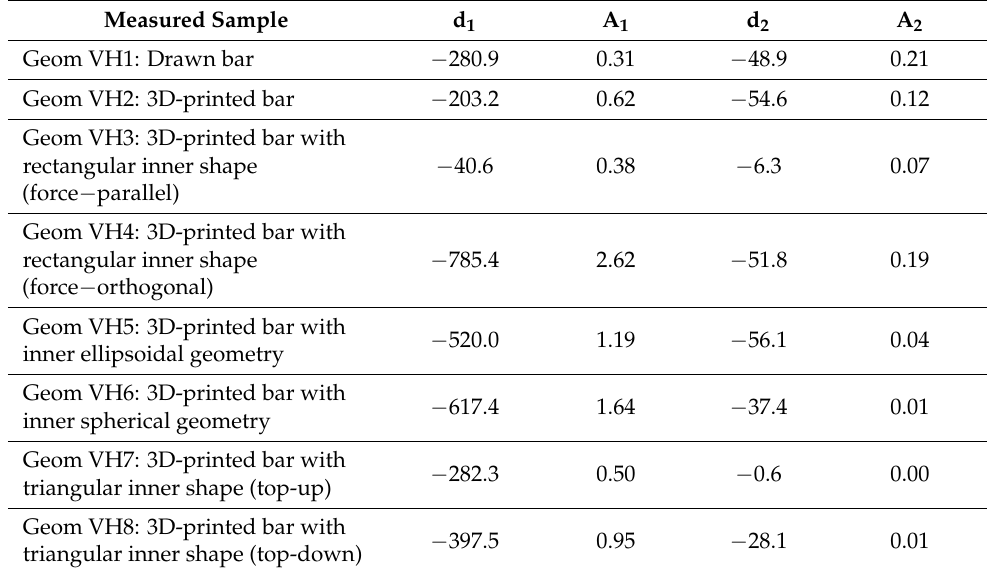
Figure 8. Acceleration data and fitted curve for a drawn bar.